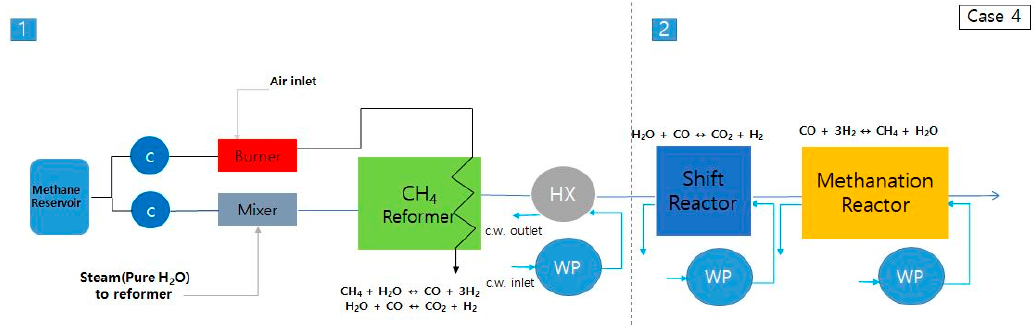
Figure 7. Schematic of Case 4 reforming system. Table 5. Results for WGS outlet side.